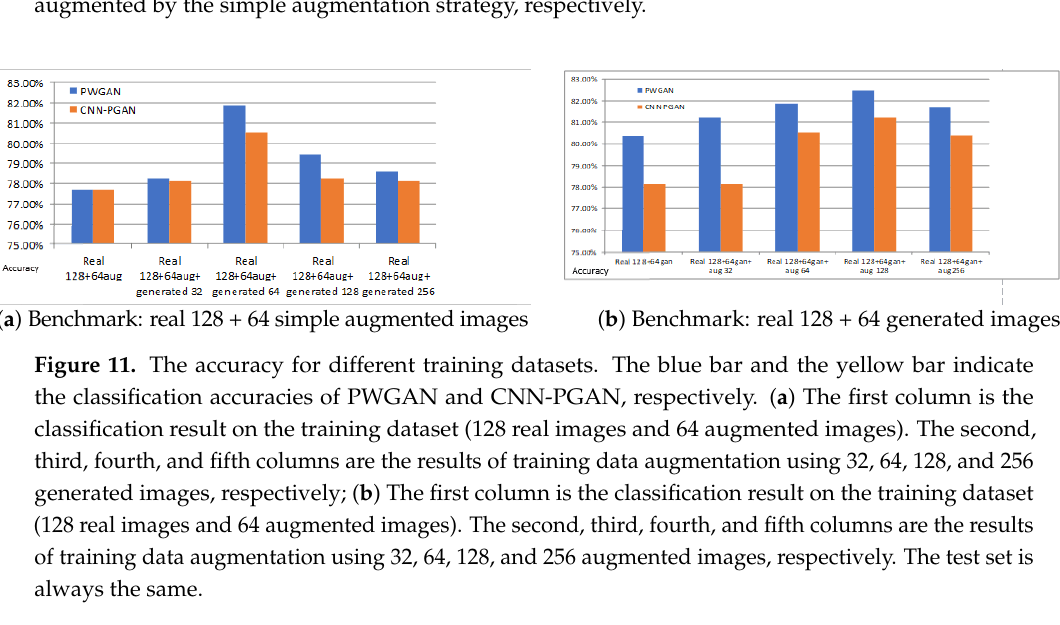
Figure 10. The classification result of different numbers of augmented training data for DataSet1. The first column is the classification result on the real 128 training images. The second, third, fourth, and fifth columns are the results of training data augmentation using 32, 64, 128, and 256 images augmented by the simple augmentation strategy, respectively.